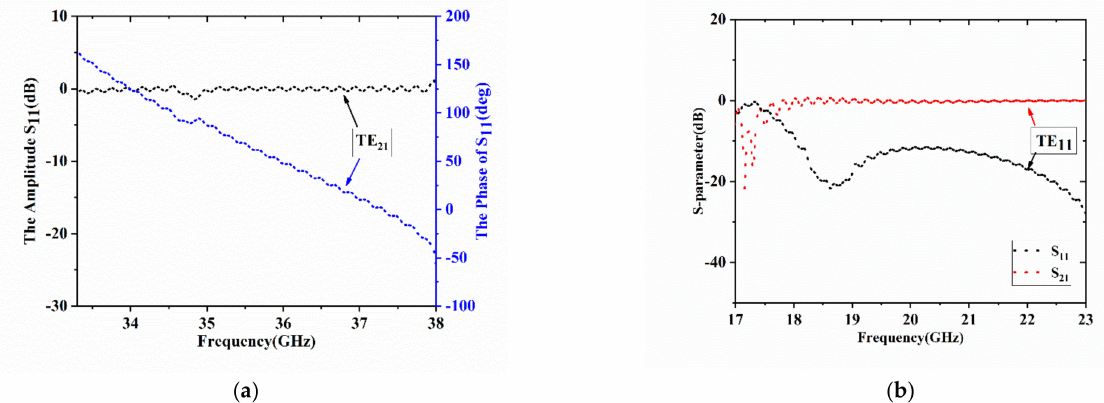
Figure 9. ( a ) Reflection amplitude (the black-dot curve) and phase (the blue-dot curve) of S 11 of TE mode, ( b ) the reflection and transmission of TE (cid:35) 1,1